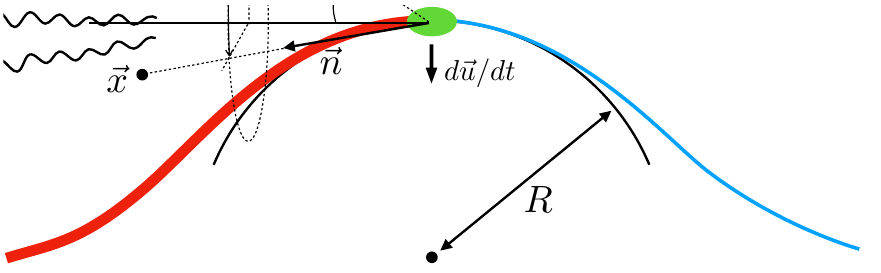
Figure 7 . Accelerating Nambu monopole on the Z strings. We approximate the string as a part of a circle with a radius R of curvature. The monopole generates the synchrotron radiation with a typical frequency !